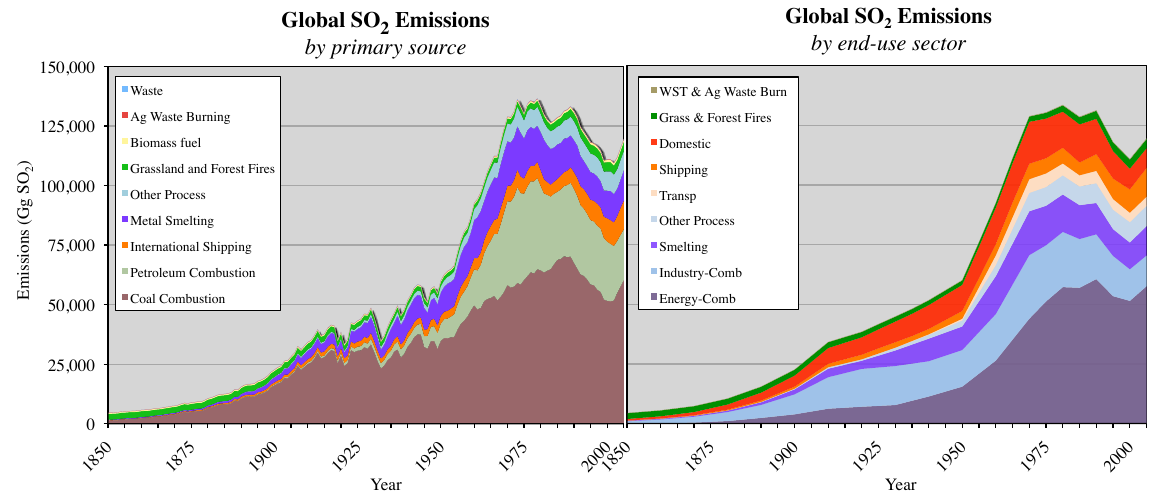
Fig. 5. Global sulfur dioxide emissions by (a) source and (b) end-use sector. Emissions by source are the primary inventory result from this work. Emissions were then mapped to sector. Included are emissions from forest and grassland fires from van der Werf et al. (2006), Schultz et al. (2008), and Mieville et al. (2010) as used in the RCP historical inventory exercise (Lamarque et al., 2010).